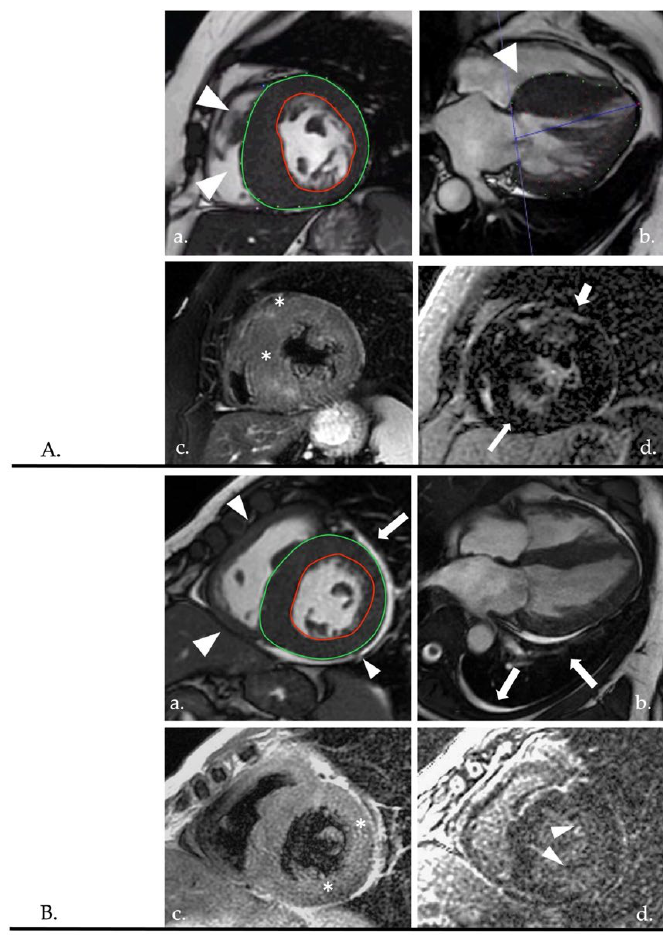
Figure 6. Panels ( A , B ) show two cases of HFrEF and myocardial hypertrophy. In panel ( A ), asym- metric hypertrophy is highlighted with prevalent involvement of the septum (images ( a , b ) showing frame of cine SA and HLA views). Patchy areas of edema (white asterisks) and LGE (white arrows) (images ( c , d )) are clearly evident in the context of hypertrophic segments, with LGE also extended to non-hypertrophic segments (thick white arrow). Panel ( A ) findings are indicative of a primitive HCM. In panel ( B ), biventricular hypertrophy (white arrowheads in image ( a ) showing a cine-frame of SA view). Image ( b ) showing a cine-frame of the HLA view with evidence of pericardial and pleural effusion (white arrows). Image ( c ) shows a T2-w sequence with evidence of faded myocardial edema (white asterisks). Image ( d ) shows an LGE sequence, with the absence of clear myocardial nulling and prevalent subendocardial enhancement (white arrowheads) with an apparent transmural distribution in the inferolateral basal segment. Compared to panel ( A ), panel ( B ) findings clearly diverged from a typical primitive HCM pattern. Panel ( B ) findings indeed refer to a hypertrophic mimic (non-treated AL type amyloidosis). HFrEF: heart failure with reduced ejection fraction; SA: short axis; HLA: horizontal long axis; LGE: late gadolinium enhancement; HCM: hypertrophic cardiomyopathy; AL: amyloid light